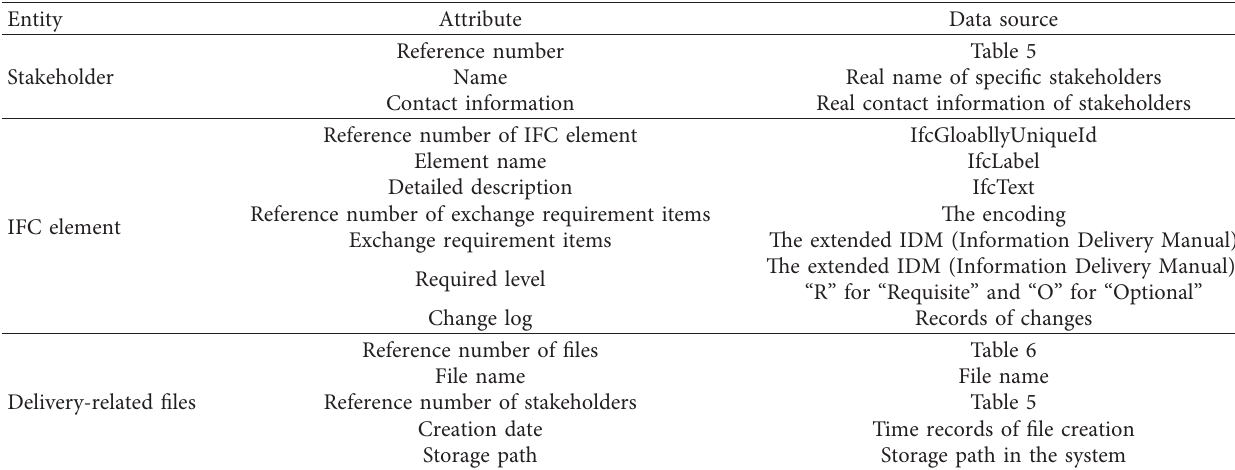
Table 7: Classification of entities and